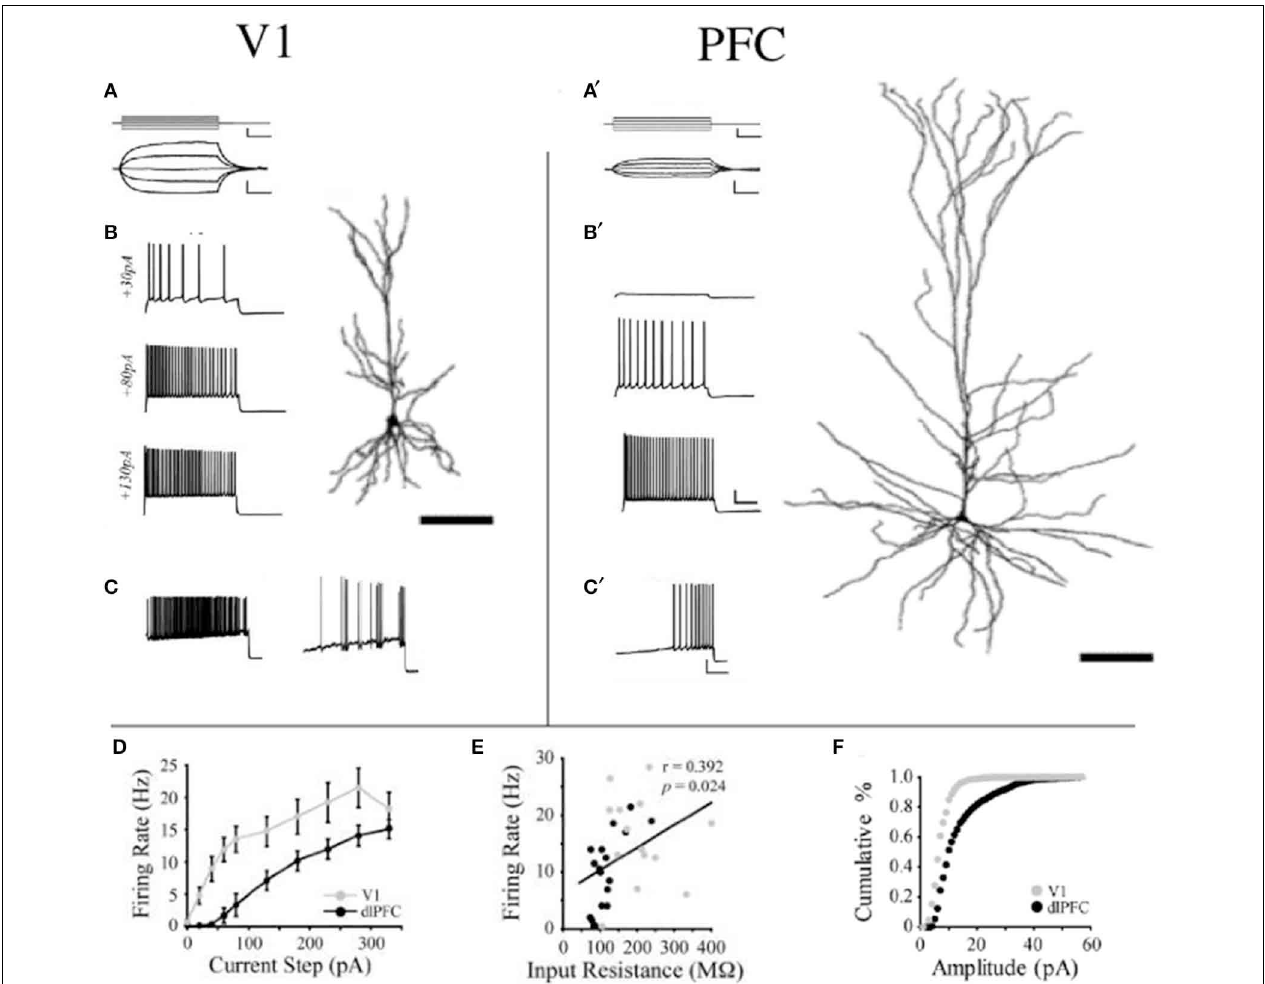
of depolarizing current steps. V1 was significantly different from PFC at steps + 20 to + 280pA ( p < 0 . 05). (E) Relationship between input resistance and firing rate is illustrated in response to a + 130pA current step for all V1 and dlPFC neurons. Linear regression (black line) demonstrates a significant positive correlation. (F) Cumulative frequency histograms of sEPSC amplitudes (1pA bins) in V1 and PFC neurons. Modified from Amatrudo et al.